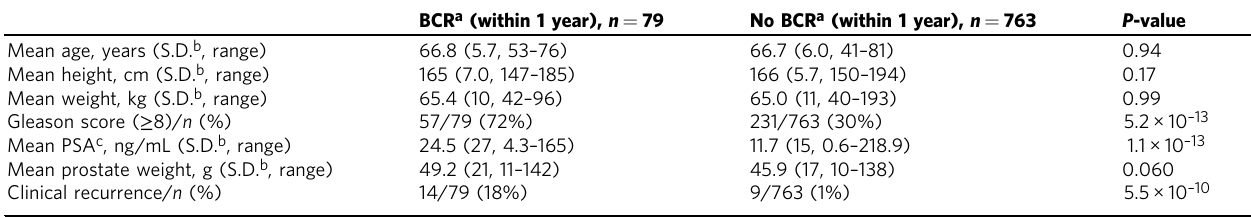
Table 1 The clinical characteristics of Nippon Medical School Hospital (NMSH)